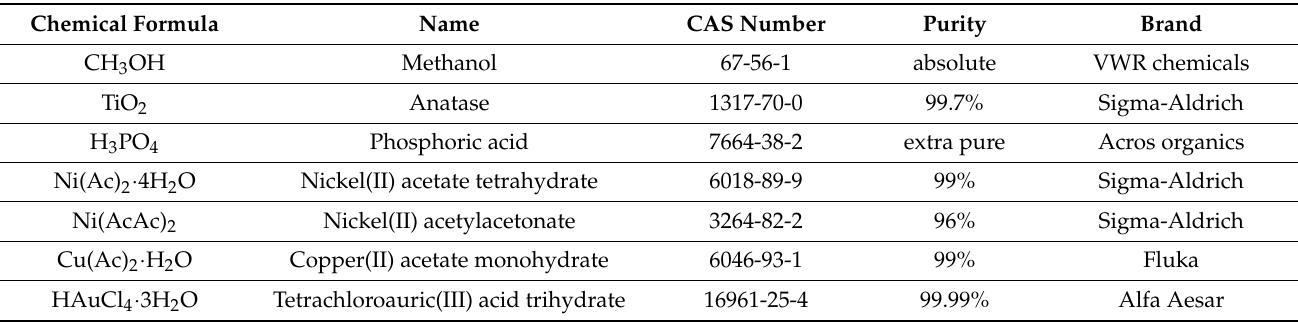
Table 3. Information on the used